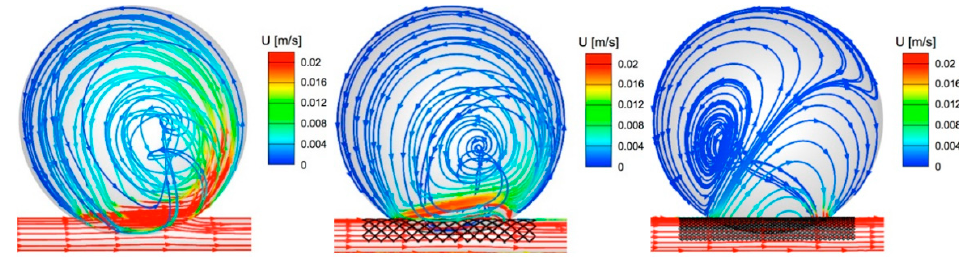
Figure 7. Velocity streamlines of the ( left ) UA, ( center ) RS, and ( right ) FD at late